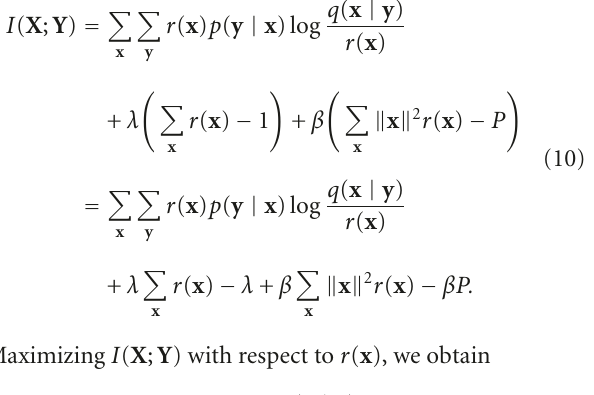
Algorithm 1: The constrained Blahut-Arimoto